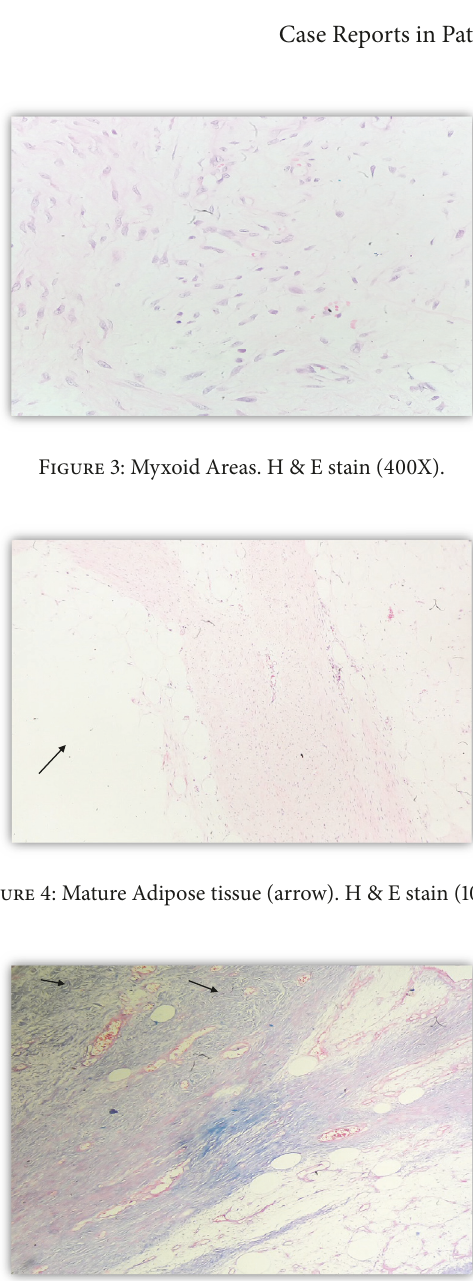
Figure 5: Alcian Blue Stain (arrows). Special stain